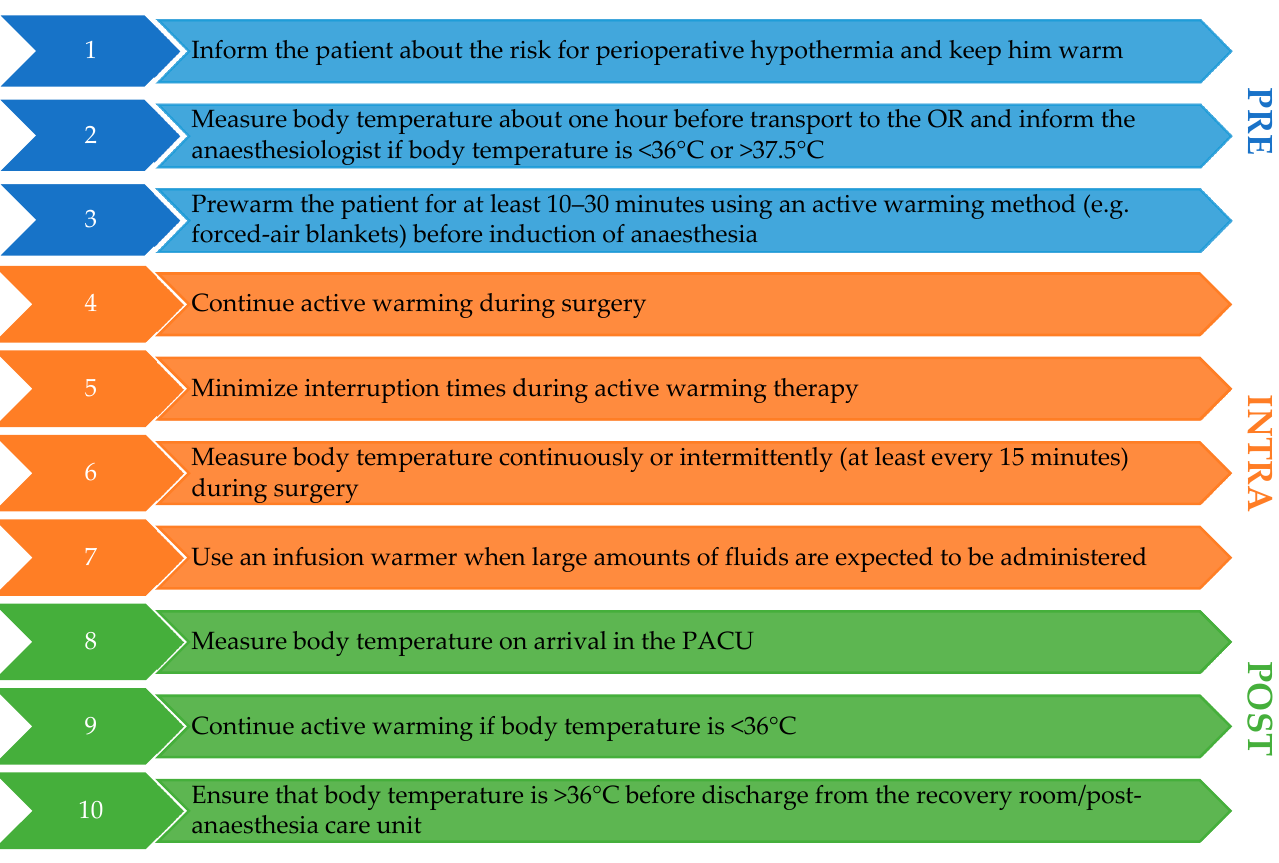
Figure 2. Ten essential points to prevent perioperative hypothermia for surgery lasting >30 min. Blue boxes refer to the pre-anaesthetic period, orange boxes to the intra-anaesthetic period, and green boxes to the post-anaesthetic period. OR: operating room; PACU: post-anaesthesia care unit.